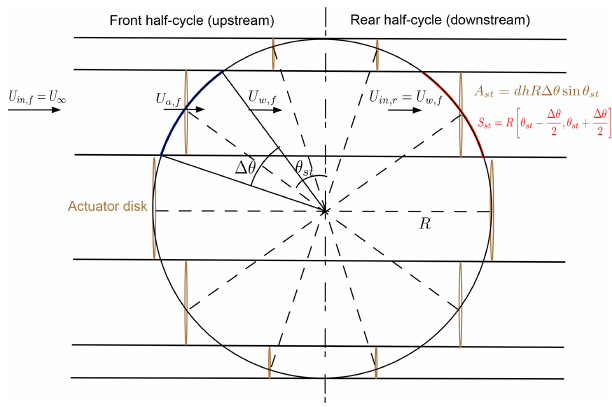
Figure 1. Schematic diagram of DMST geometrical configuration with N st = 5.